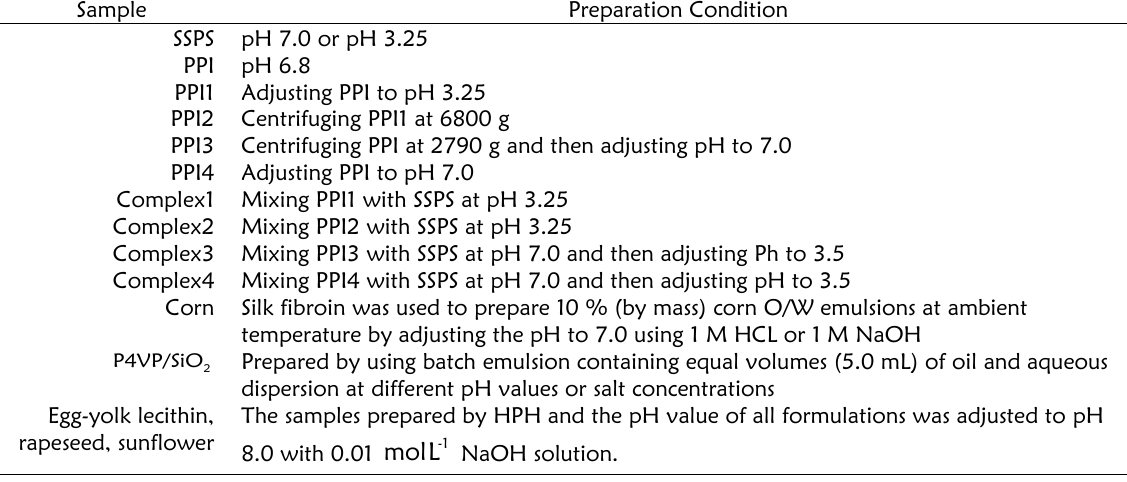
Table 2: Preparation conditions of materials used [19, 20, 26, 27].